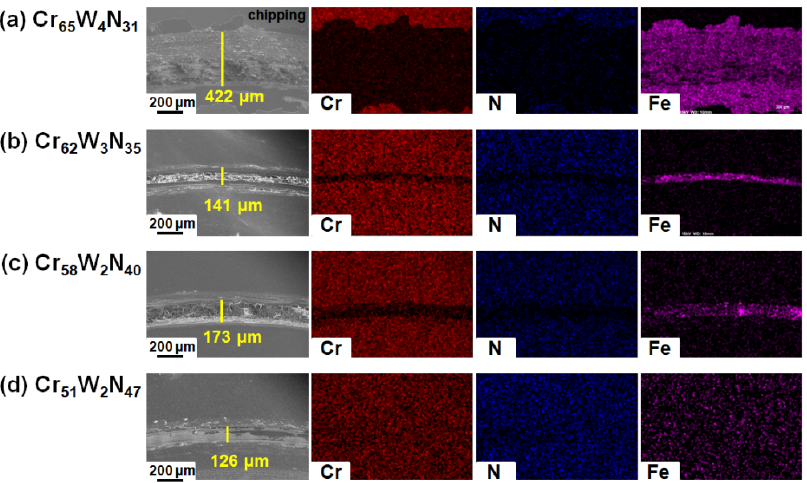
Figure 9. Wear scars and elemental mapping of ( a ) Cr 65 W 4 N 31 , ( b ) Cr 62 W 3 N 35 , ( c ) Cr 58 W 2 N 40 , and ( d ) Cr 51 W 2 N 47 coatings.